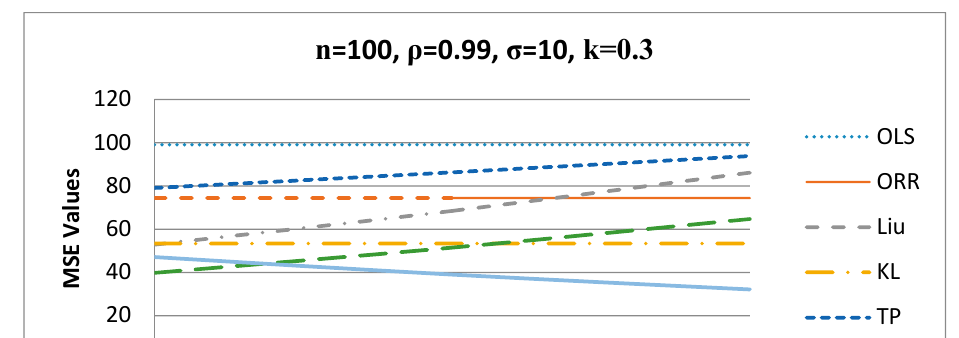
Figure 3. MSE values versus σ values.